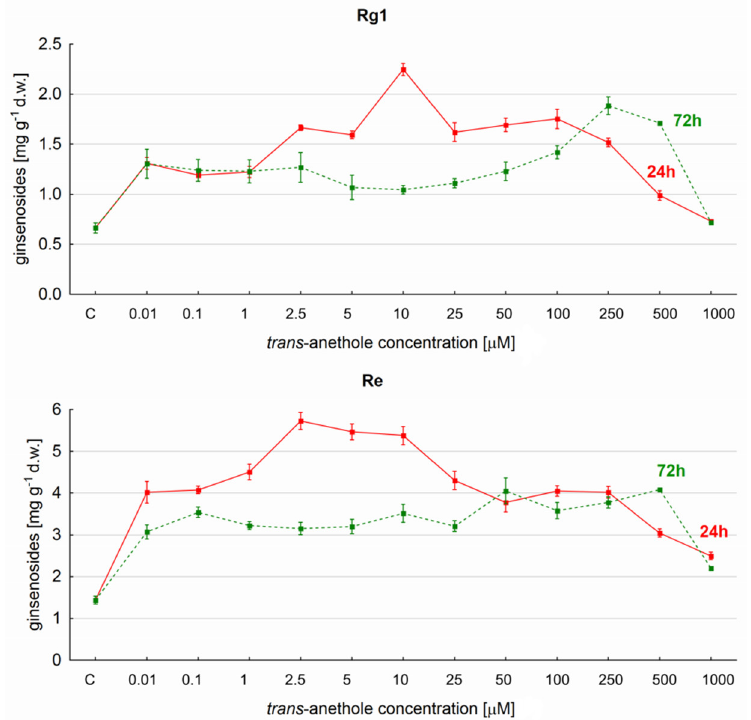
Figure 3. The effect of trans -anethole concentration on the production of the Re and Rg1 ginsenosides in Panax quinquefolium hairy roots after 24- and 72-h